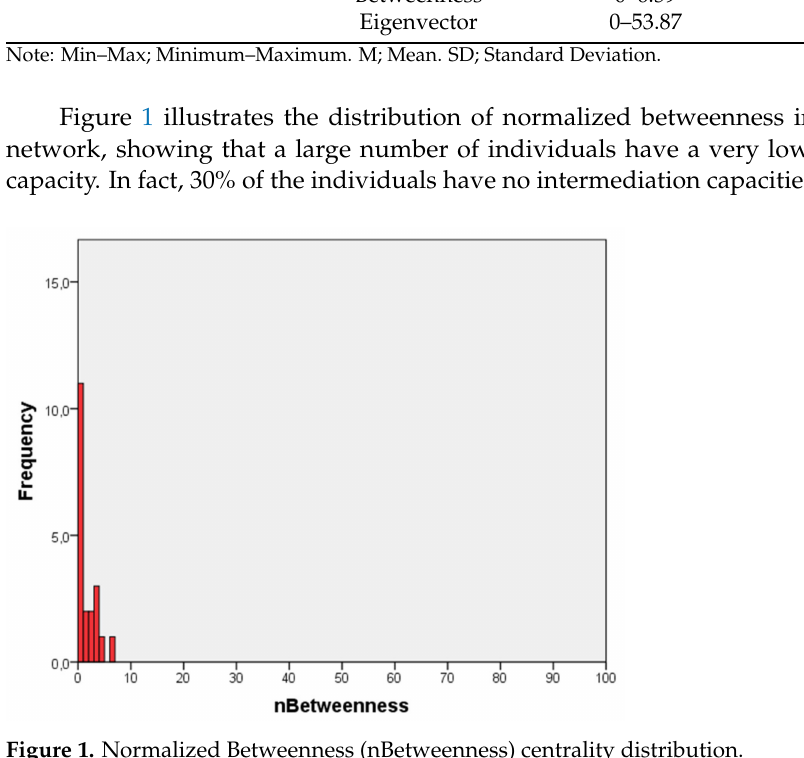
Figure 1. Normalized Betweenness (nBetweenness) centrality distribution. A correlational analysis between the different variables, stress, cannabis use intention and friendship and consumption networks is shown in Table